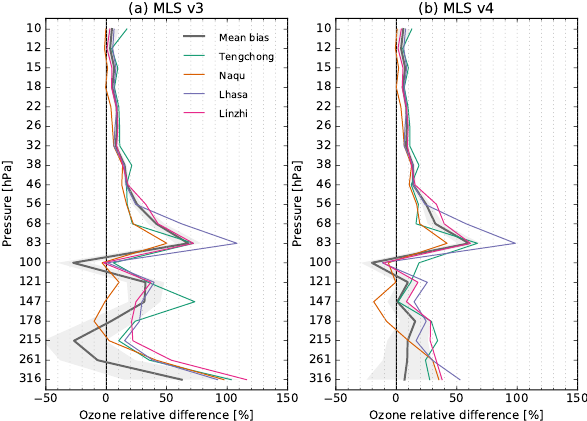
Figure 15. Relative differences between ECC ozonesonde observa- tions and retrievals of ozone volume mixing ratio from (a) MLS v3 and (b) MLS v4. Grey lines and shading represent the mean bias and twice the standard error of the mean bias from the core vali- dation analysis, as shown in Fig. 11. Coloured lines represent rela- tive differences between mean ozonesonde observations convolved to MLS pressure levels and time-mean gridded MLS observations during each study period (see, e.g. Fig. 14) interpolated to the re- spective ozonesonde launch site.